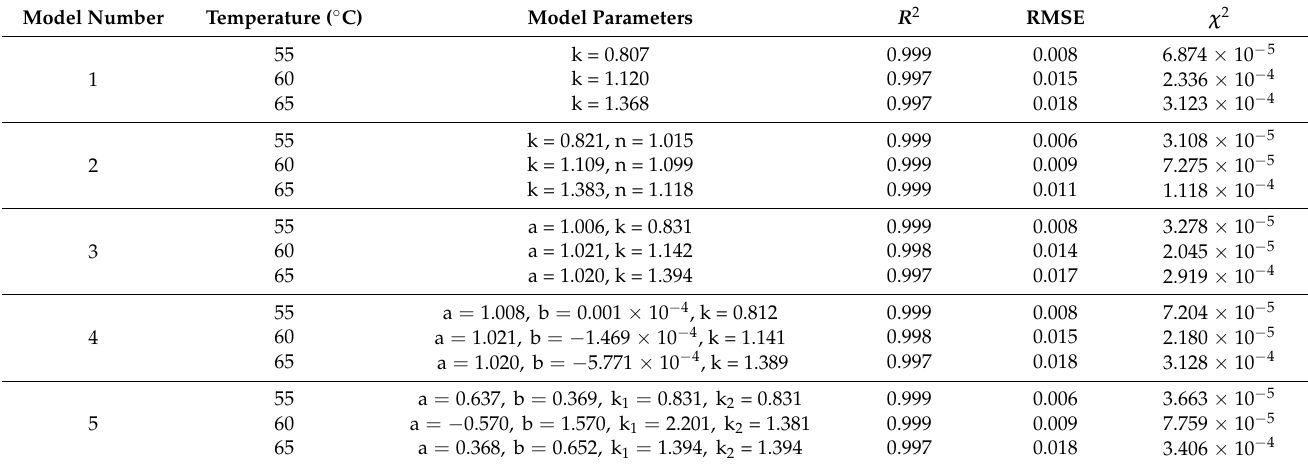
Table 2. Parameter values and statistical results of the thin layer drying models.